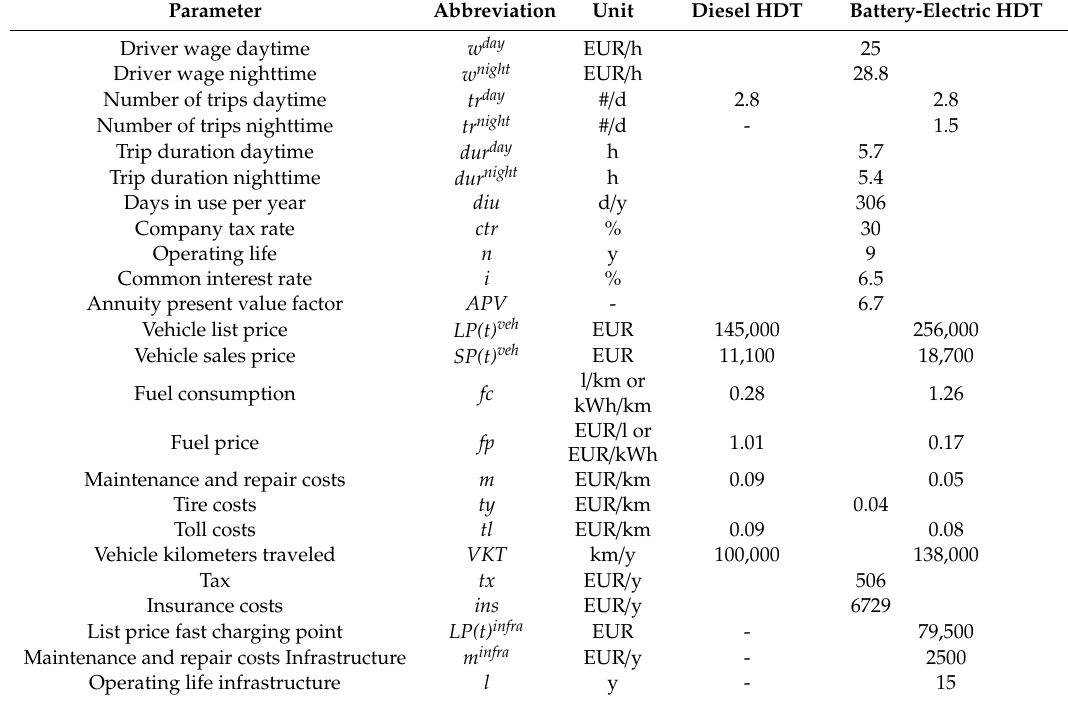
Table 4. Techno-economic parameters for logistics parameters and 26t HDT in